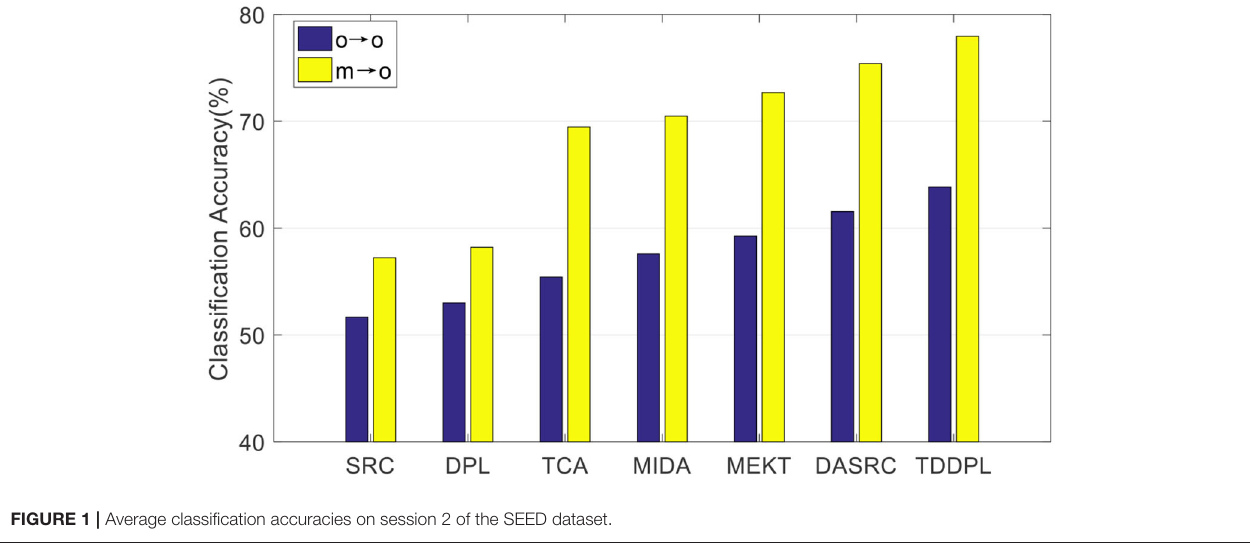
FIGURE 1 | Average classification accuracies on session 2 of the SEED dataset.